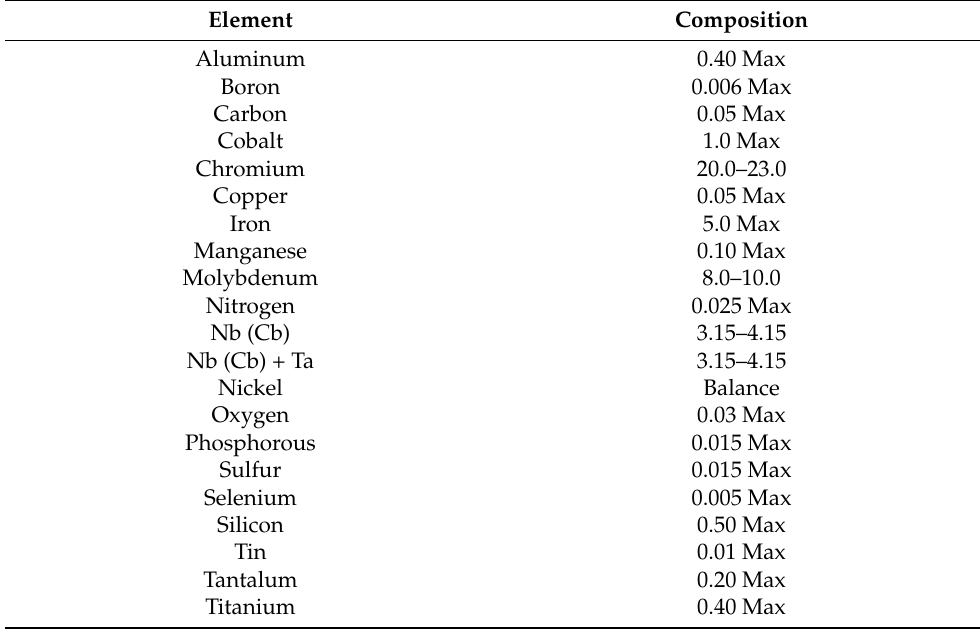
Table 1. Chemical composition of Inconel 625 from